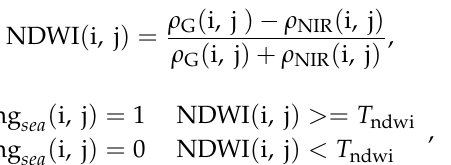
Figure 1. Flowchart of our proposed detection algorithm.